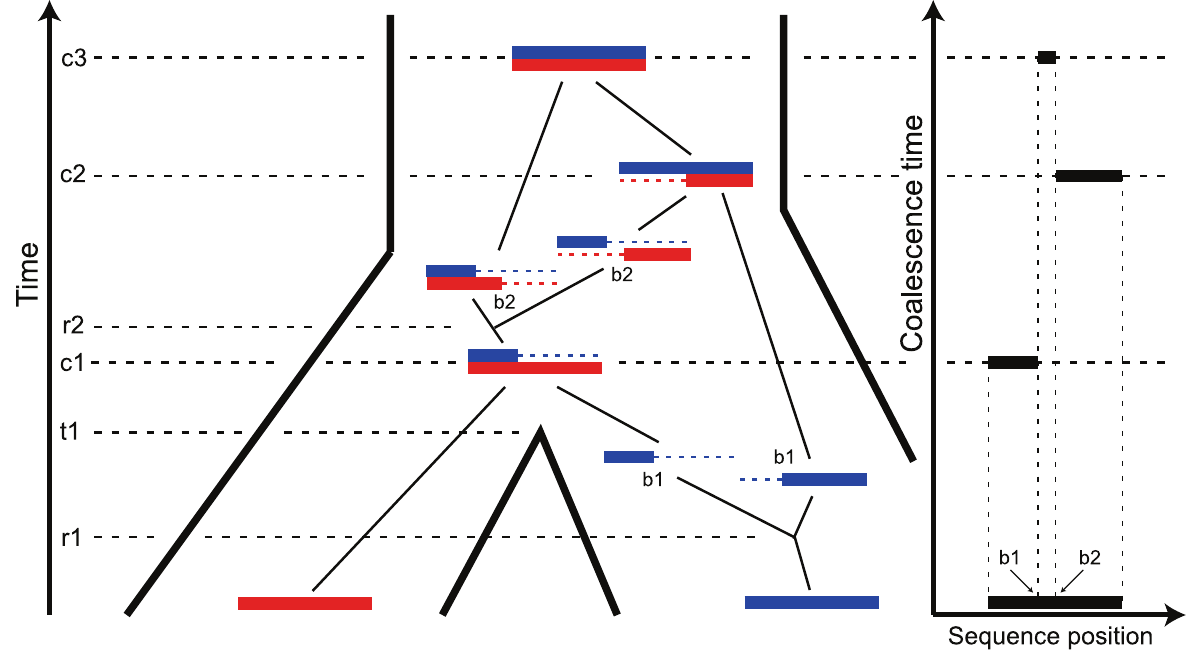
Figure 1. The ancestry of two genomic sequences. The figure illustrates the ancestry of two genomic sequences (in red and blue) from two different populations. Tracing their ancestry back in time, the first event we see is a recombination (at time r 1 and sequence position b 1 ) within the ‘‘blue population’’. This is followed by the population split (at time t 1 ), and thus the ‘‘red genome’’ enters the ancestral population as a contiguous segment, while the ‘‘blue genome’’ enters the ancestral population in two fragments. The process in the ancestral population now under goes coalescence events (at times c 1 , c 2 , and c 3 ) and a recombination event (at time r 2 and sequence position b 2 ). A consequence of the coalescence process with recombination is that the coalescence times, and thus the sequence divergence, changes along the genomic alignment at the recombination break points (illustrated on the right).